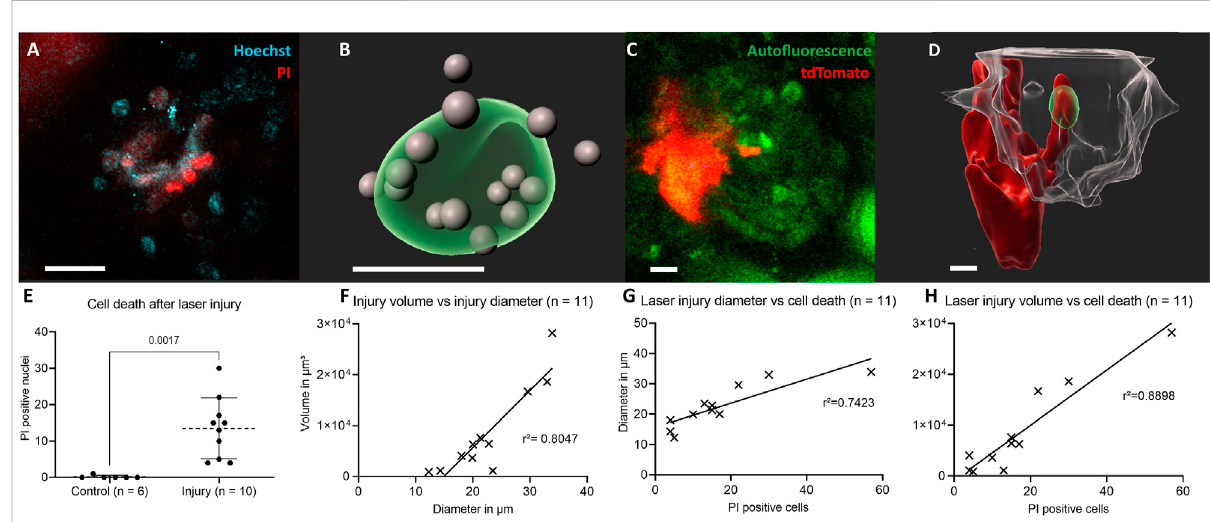
FIGURE 2 Characterizationofthelaser-inducedinjurymodel. (A) Two-dimensionalsliceviewwithHoechstandPIstainingsaroundthelaserinjuryand (B) corresponding three-dimensional rendering of the auto fl uorescent area of a glomerular laser injury (green) with propidium iodide (PI) and Hoechst double positive cell nuclei in grey. (C) Two-dimensional slice view of renin cells (red) directly invading the laser injured area (green) and (D) corresponding three-dimensional rendered glomerulus (transparent-white). (E) Number of propidium iodide and Hoechst double positive nuclei30 minfollowinglaserirradiationcomparedtocontrol.Mean±SDareindicatedandcomparedwithunpaired,two-tailed t testcalculating p = 0.017 for statistical signi fi cance. (F) Positive linear correlation between laser injury volume and diameter. The geometric parameters were calculated with object statistics in Imaris 9.7.2 based on the auto fl uorescent area of the laser injury. The underlying geometric mean diameter amounted to 22.60 ± 7.05 µm and the volume to 8604 ± 8818 μ m 3 and were normally distributed in each case. (G) PI positive cells and laser injury diameter of auto fl uorescent area. (H) PI and laser injury volume of auto fl uorescent area. White scale bars represent 10